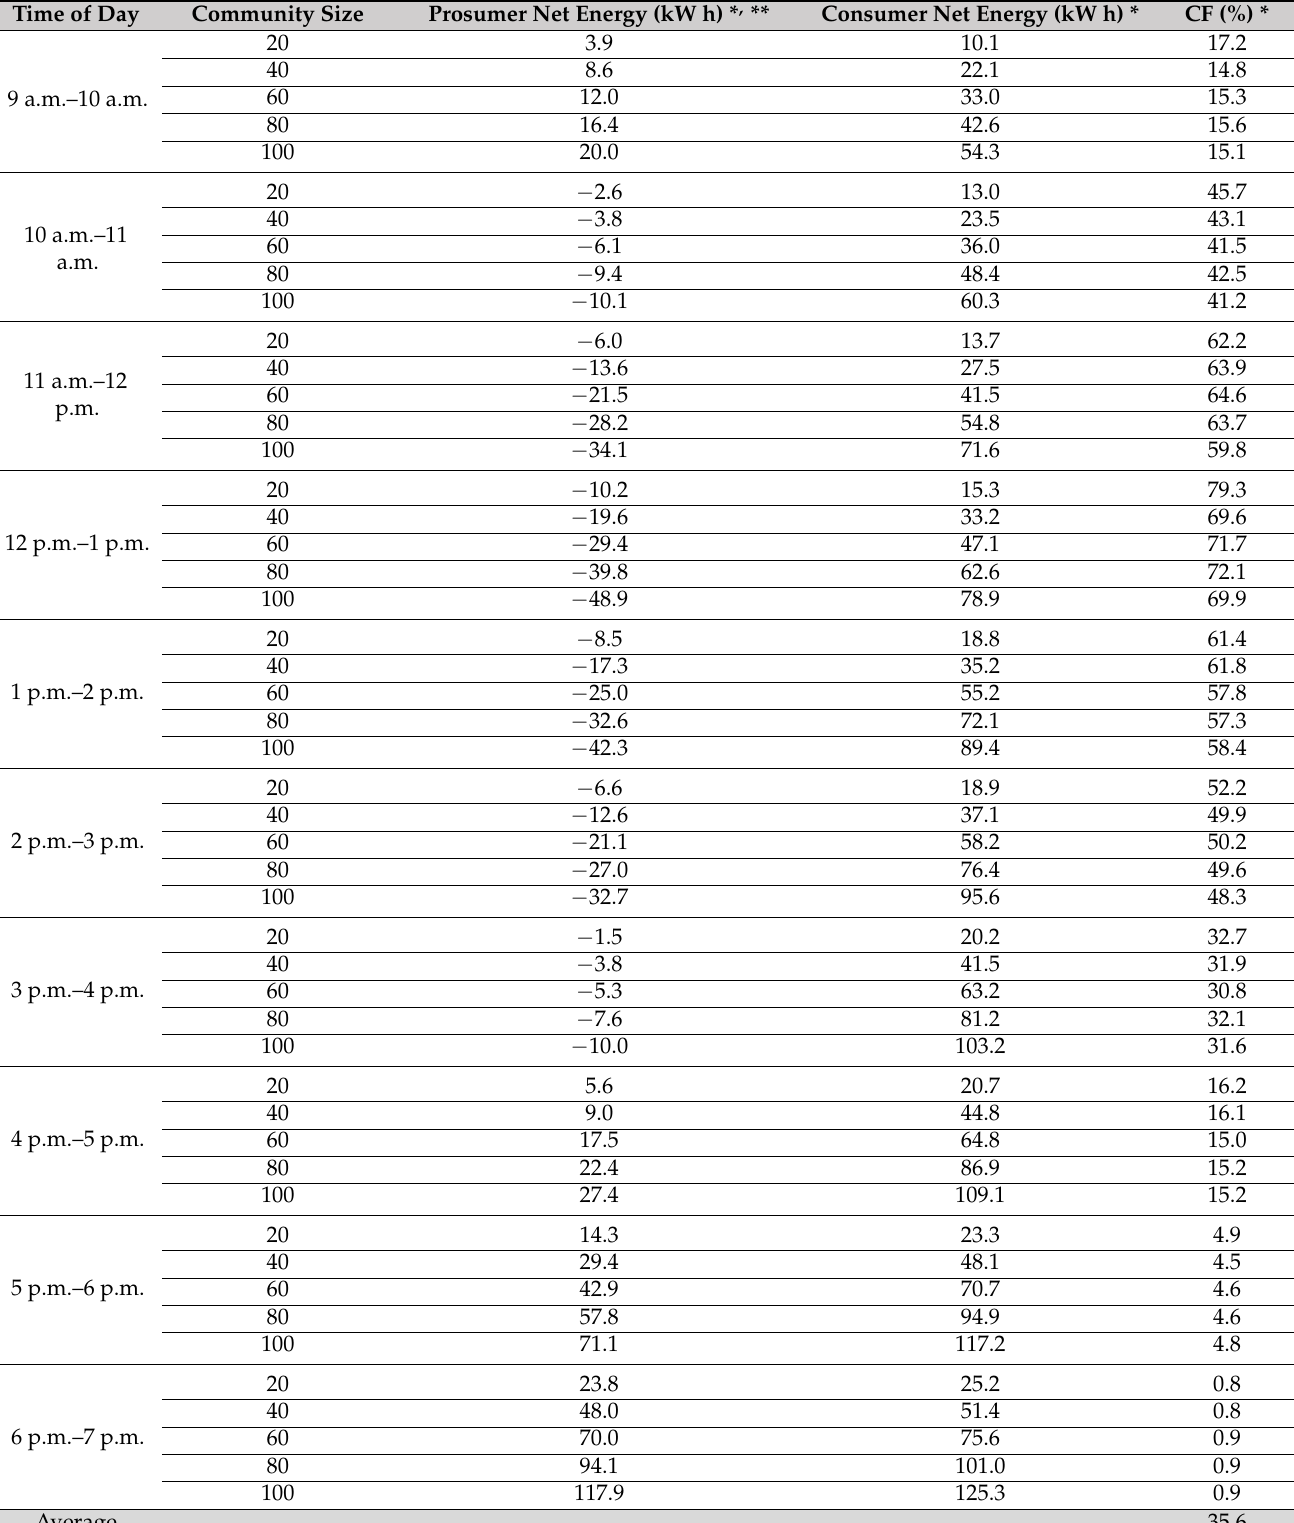
Table 1. Energy surplus, energy deficit, and complementarity factor for various community sizes with equal numbers of prosumers and